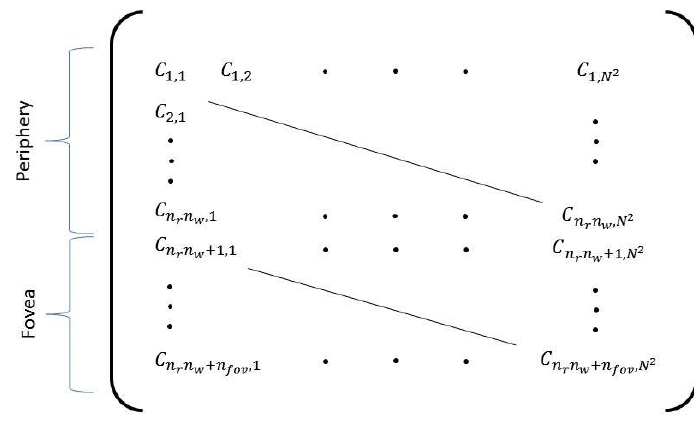
Figure 13. Illustration of the organization of a log-polar foveating transformation matrix.